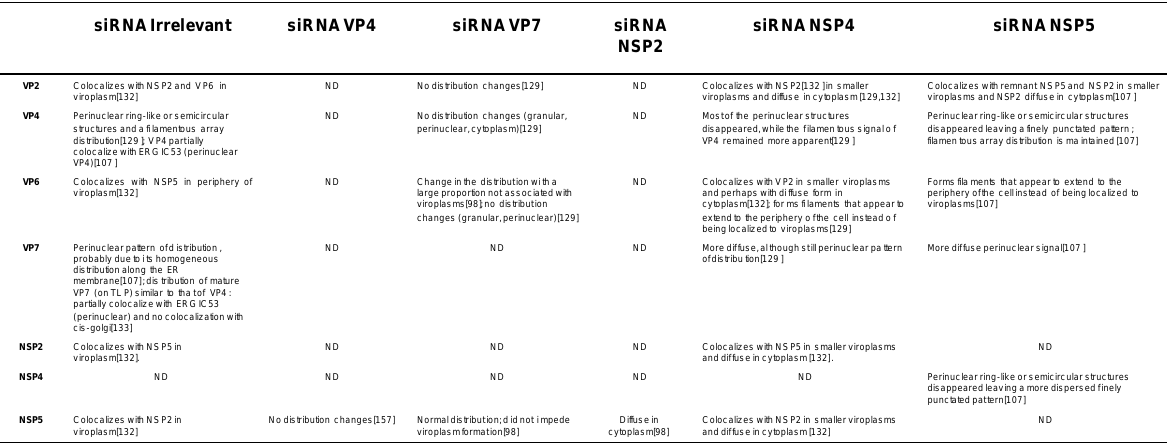
Effect of Silencing the Expression of Individual Viral Proteins on Expression and Distribution of Viral Proteins in Rotavirus-Infected Cells